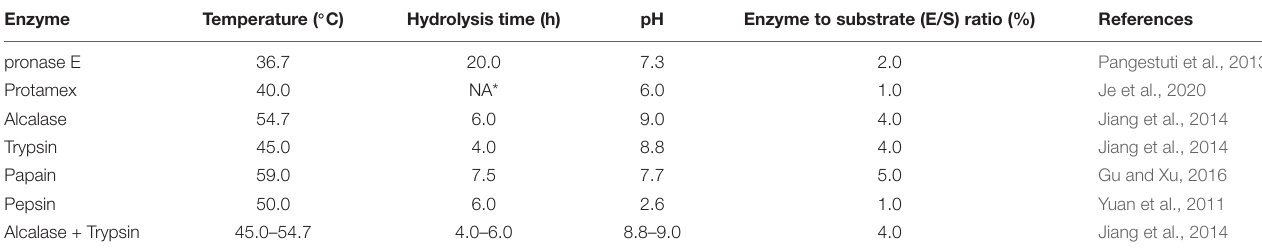
TABLE 1 | The optimized enzyme hydrolysis